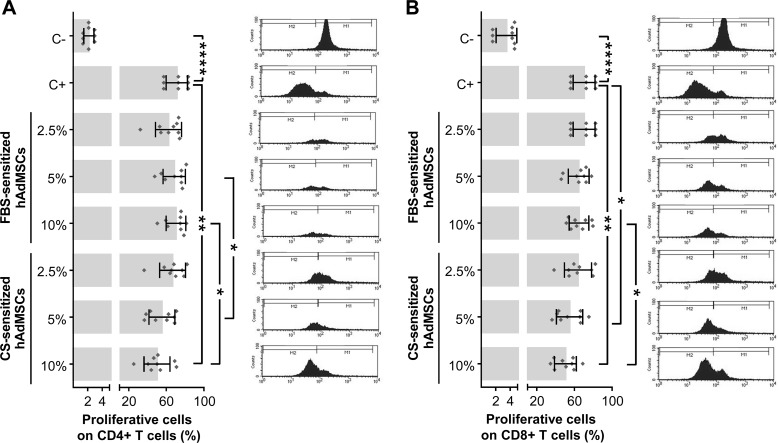
Proliferative ability of in vitro-stimulated T cells cocultured in the presence of FBS or CS-sensitized hAdMSCs. After 6 days of hAdMSCs sensitization with different concentrations (2.5, 5, and 10%) of FBS or CS in the culture medium (DMEM supplemented with 1% penicillin/streptomycin and 1% glutamine), these hAdMSCs (three different cell lines) were cocultured for 6 days with carboxyfluorescein succinimidyl ester (CFSE)-labeled peripheral blood lymphocytes (PBLs) (three different donors) during in vitro stimulation with T cell activation/expansion beads. As positive control (C+), stimulated PBLs without hAdMSCs were used, and as negative control (C−), non-stimulated PBLs were included. After coculture with hAdMSCs, PBLs were collected and stained with anti-CD4 and anti-CD8. The CFSE dilution assay allowed us to identify proliferative T cells (CFSE low) and non-proliferative T cells (CFSE high). Graphs representing individual values (n = 9), as well as mean ± SD of three independently performed experiments, together with representative histograms of each condition, are shown for CD4+ T cells (A) and CD8+ T cells (B). Data were statistically analyzed using a one-way ANOVA test followed by a Fisher’s least significant difference test to compare equivalent concentrations of CS and FBS, C− with C+, and C+ with each treatment group. *p ≤ 0.05; **p ≤ 0.01; ****p ≤ 0.0001.